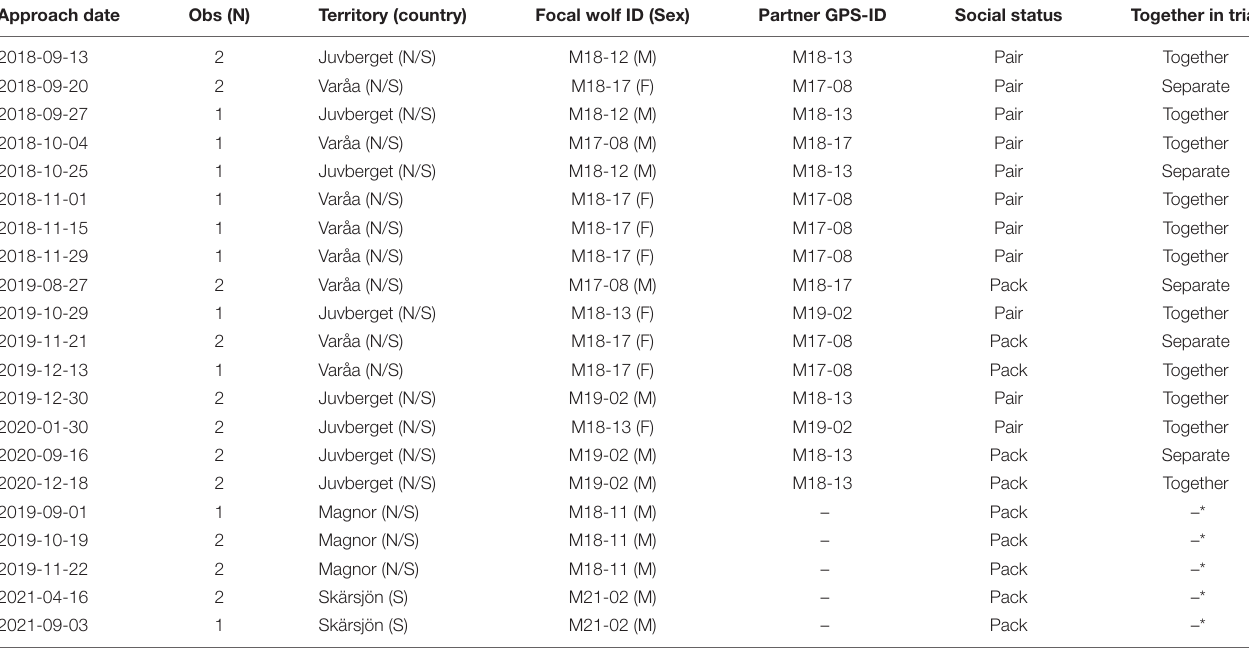
Date of each approach trial, the number of human observers (Obs), name and country of the four wolf territories (N = Norway, S = Sweden), identity and sex of every focal wolf for approach, identity of GPS-collared partner-wolves, social status (scent-marking pair or pair with pups, i.e., pack), and whether the GPS-collared pair was together or not during the approach trial. *Only one of the adults